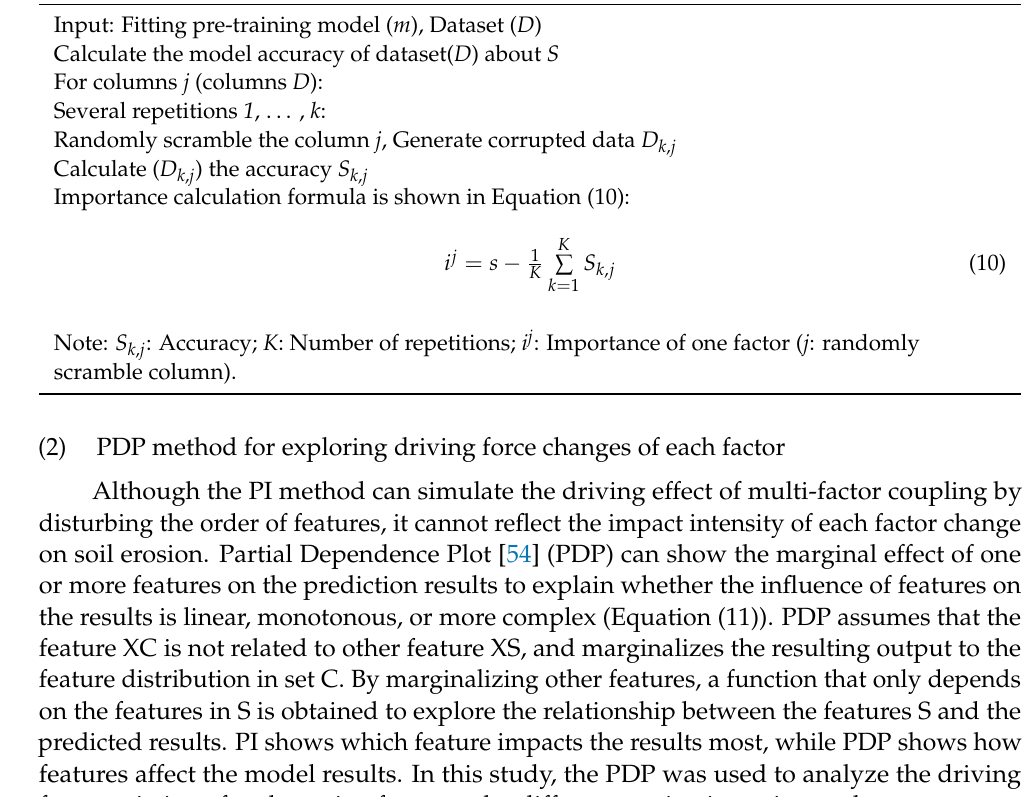
Algorithm 1. PI implementation